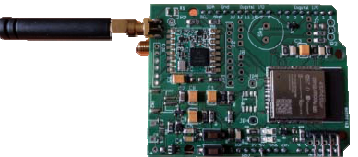
Figure 7 : Syslor daughter board version 1